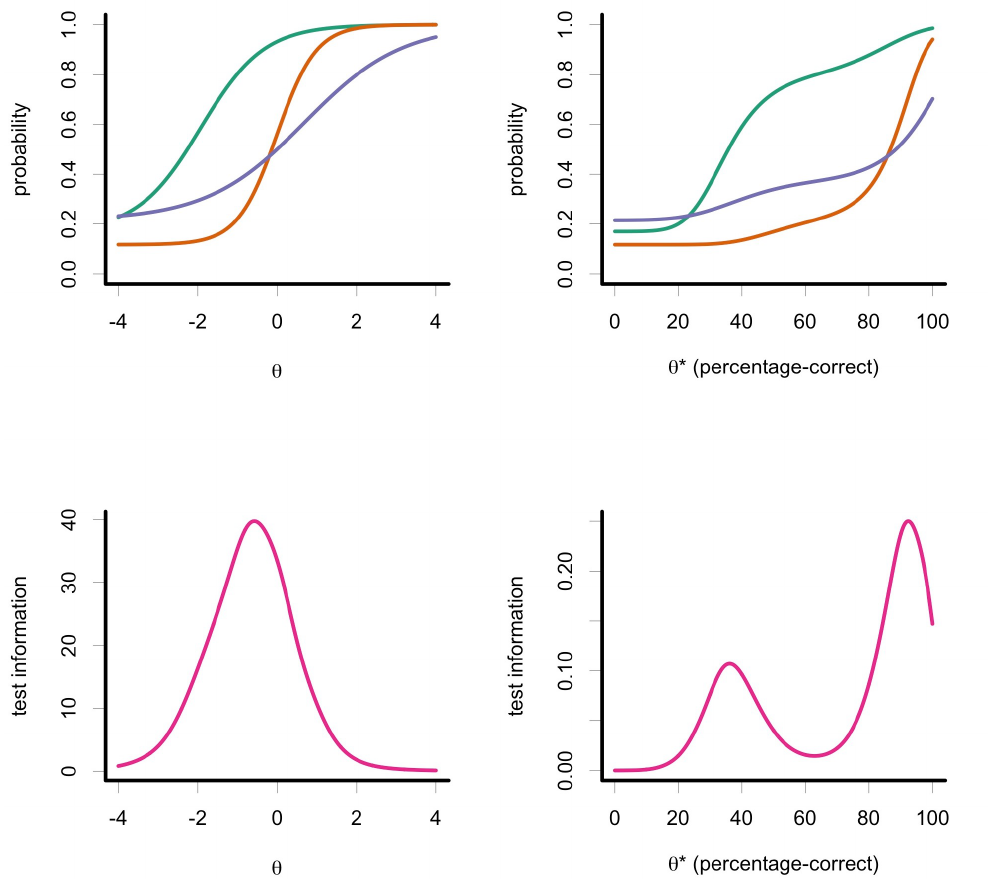
Figure 4. Item response functions (upper row) and test information functions (bottom row) on the original θ metric and on the transformed percentage-correct metric θ (cid:63)